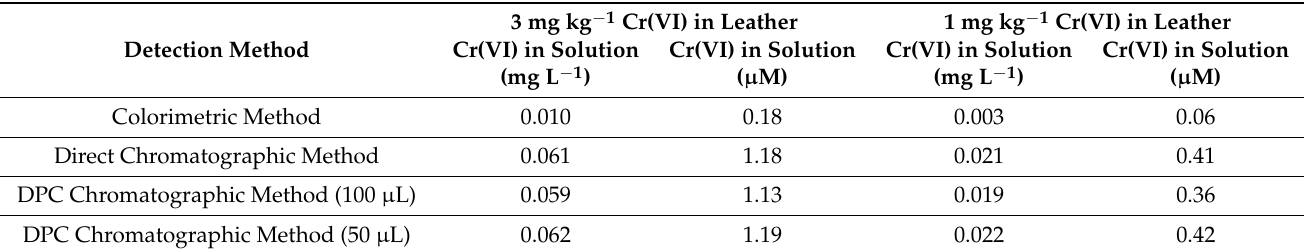
Table 1. Theoretical concentrations of Cr(VI) in solution for the current and proposed compliance limits in leather.